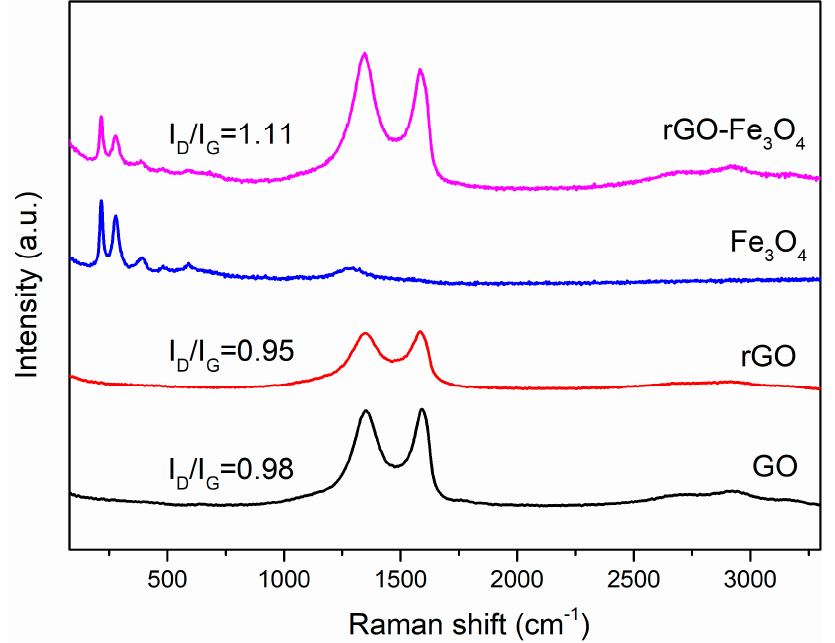
Figure 3. Raman spectra of GO, rGO, Fe 3 O 4 , and rGO–Fe 3 O 4 nanocomposites.